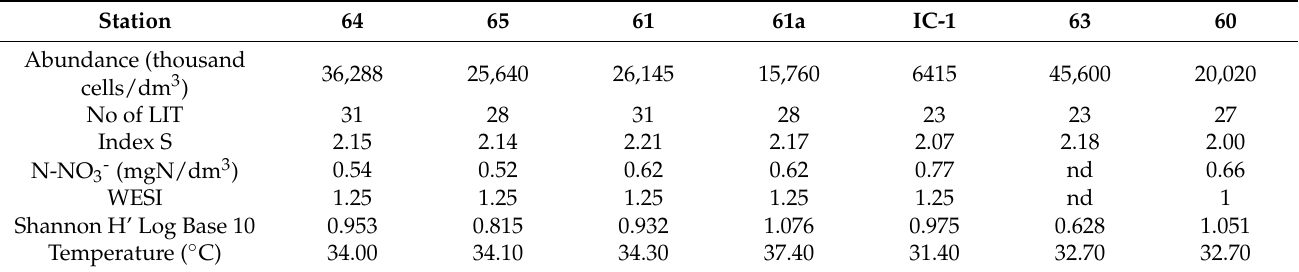
Table 4. Saprobity, Shannon, WESI indices, LIT richness, abundance and main environmental variables’ value at the stations of the Tashlyk reservoir. The stations are located in the direction of the reservoir axis from the upper to the lower.